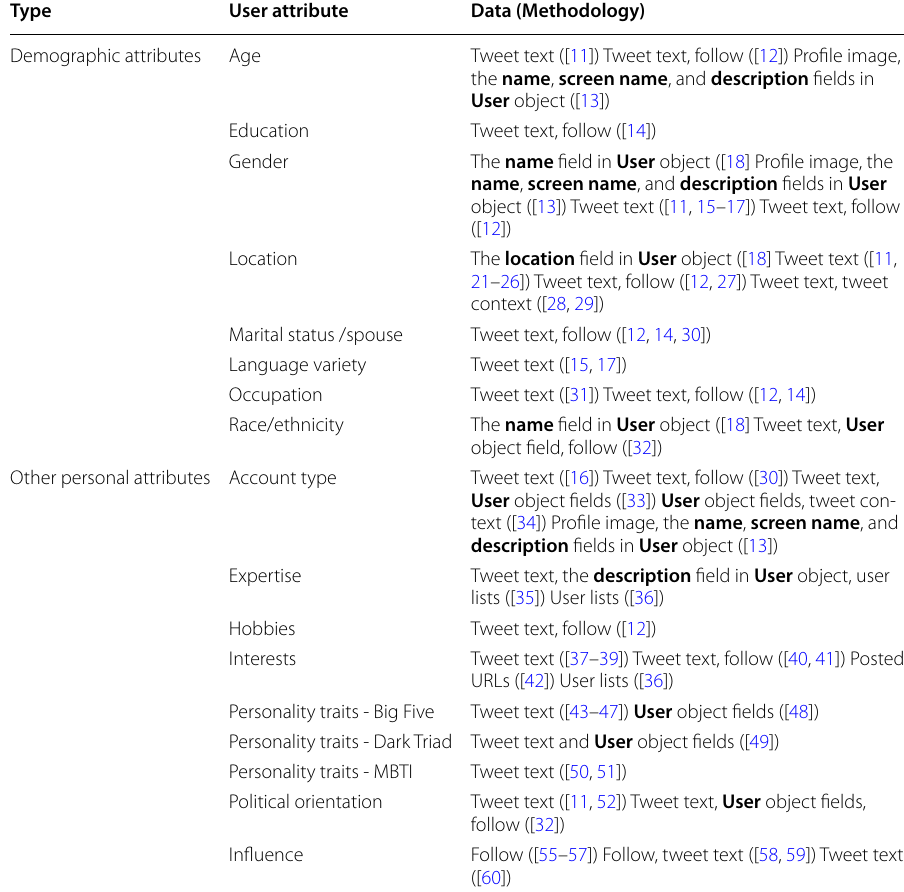
Table 1 Summary of the derivable user attributes, necessary data, and existing methodologies